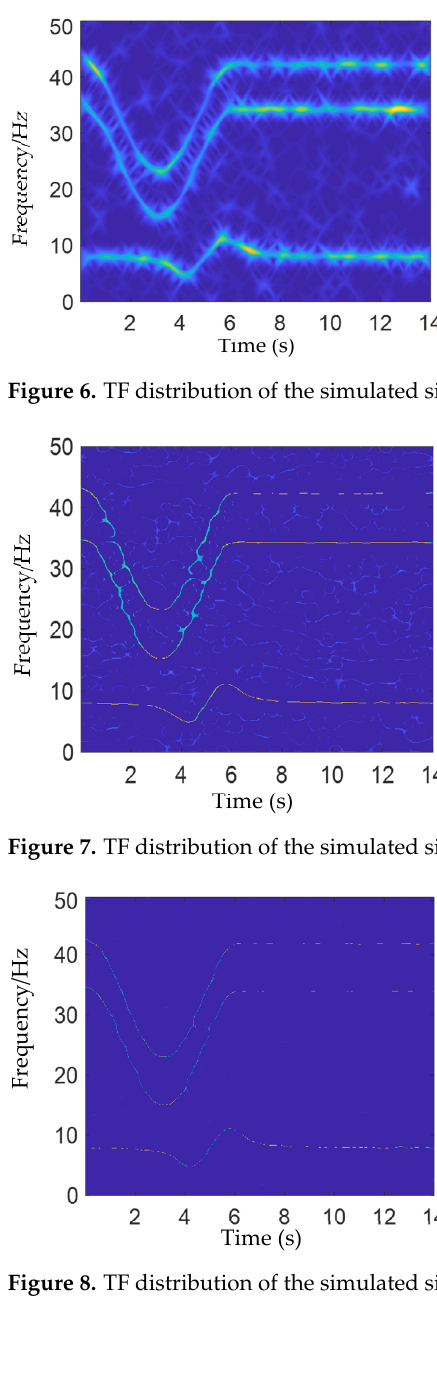
Figure 5. Time-domain waveform of the simulated signals with noise.